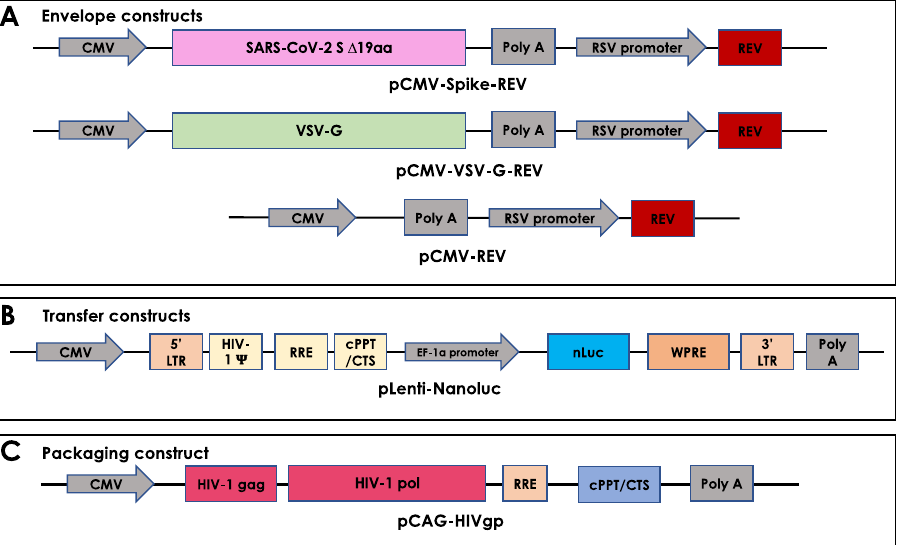
Figure 1. Schematic representation of constructs developed as part of a third-generation lentiviral-based system to produce VP pseudotyped using either SARS-CoV-2 S, VSV-G or no-envelope protein encoding Nluc. ( A ) Envelope, ( B ) packaging, and ( C ) transfer